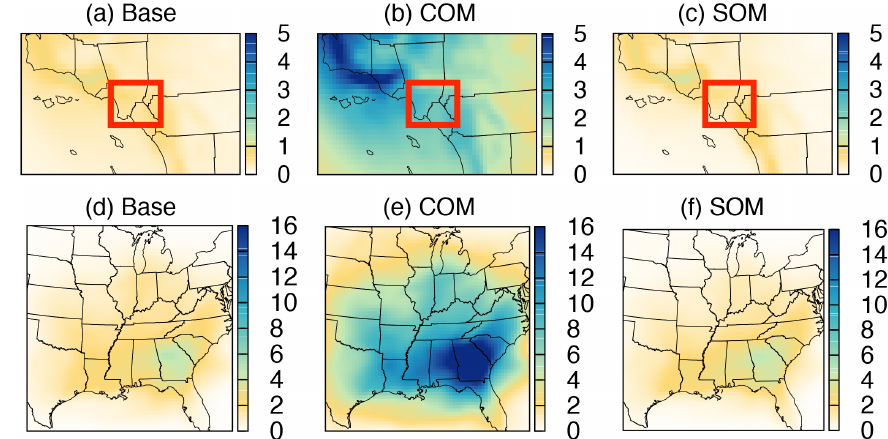
Figure 4. 14-day averaged SOA concentrations at (a) Los Angeles and (b) Riverside for the Base, Base-OLIG, SOM, SOM-OLIG simulations resolved by the precursor/pathway.